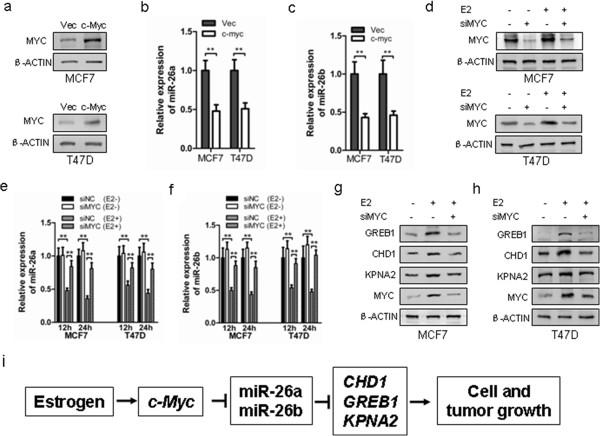
c-MYC is required for 17β-estradiol repression of miR-26 expression. (a) Expression of endogenous c-MYC protein in MCF-7 and T47D cells transfected with pcDNA3.1-Vec of pcDNA3.1-c-MYC. TaqMan stem-loop quantitative real-time polymerase chain reaction (qRT-PCR) analysis of the expression of miR-26a (b) and miR-26b (c) in MCF-7 and T47D cells after forced expression of c-MYC. (d) Expression of endogenous c-MYC protein in 17β-estradiol (E2)-treated MCF-7 and T47D cells transfected with small interfering RNA (siRNA) control or siMYC. TaqMan stem-loop qRT-PCR analysis of the expression of miR-26a (e) and miR-26b (f) in E2-treated MCF-7 and T47D cells transfected with the indicated c-MYC siRNA. U6 was used as an internal control. (g) Expression of endogenous CHD1, GREB1, KPNA2 and c-MYC protein in E2-treated MCF-7 cells transfected with siRNA control or siMYC. (h) Expression of endogenous CHD1, GREB1, KPNA2 and c-MYC protein in E2-treated T47D cells transfected with siRNA control or siMYC. β-ACTIN was used as input control. (i) A model of estrogen promotion of c-MYC expression, which suppressed miR-26a and miR-26b and resulted in increased expression of CHD1, GREB1 and KPNA2 and subsequent enhanced cell growth. **P < 0.01.